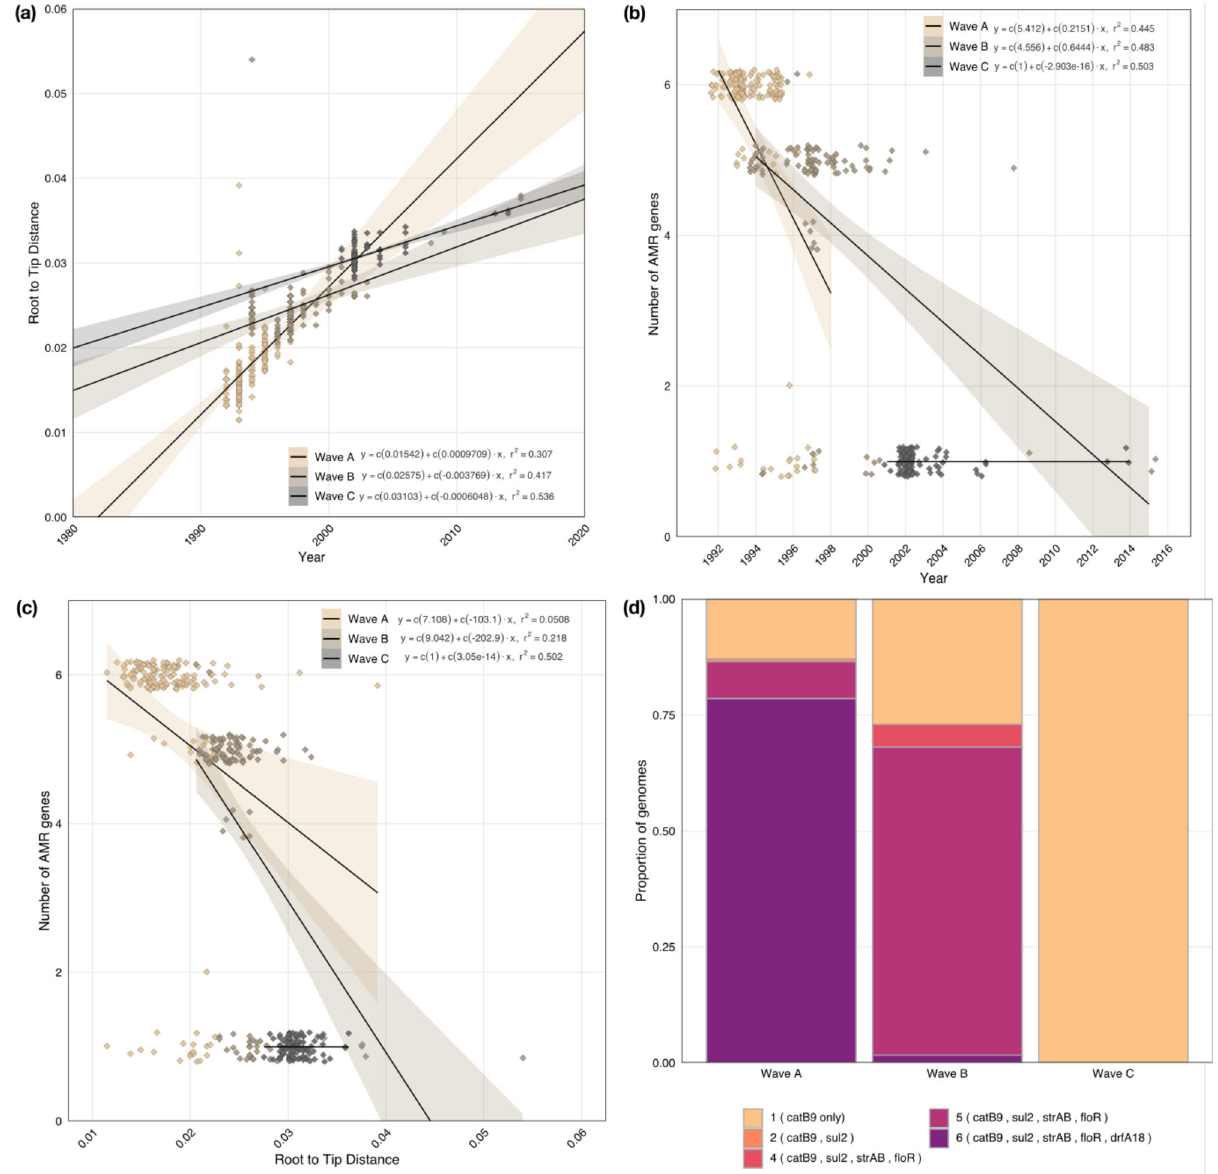
Fig. 3 Evolutionary dynamics of V. cholerae O139. a – c Linear regression plots of ( a ) the relationship between the RTT and year of isolation, i.e., the SNP accumulation rate of each of the O139 waves, ( b ) the number of AMR genes per genome, plotted per year of isolation, ( c ) the relationship between the number of AMR genes and root to tip distance (RTT). For ( a – c ), points are colored by wave (see key). The mean RTT is depicted by the linear regression line, with standard error depicted by the shaded bars. R 2 values and equations of the lines are also shown in the plots. d The proportion of varying numbers of AMR genes carried by each of the O139 waves/clades. Bars are colored by number of genes (see